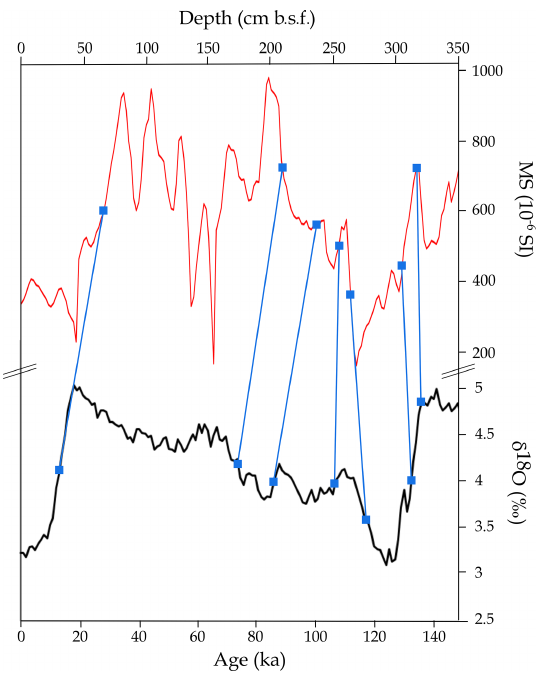
Figure 2. Alignment between the MS from core ANTA91-8 (red) and the LR04 benthic δ 18 O stack (black) using the AnalySeries software (Paillard et al., 1996). Blue squares and connecting lines mark the tie points between